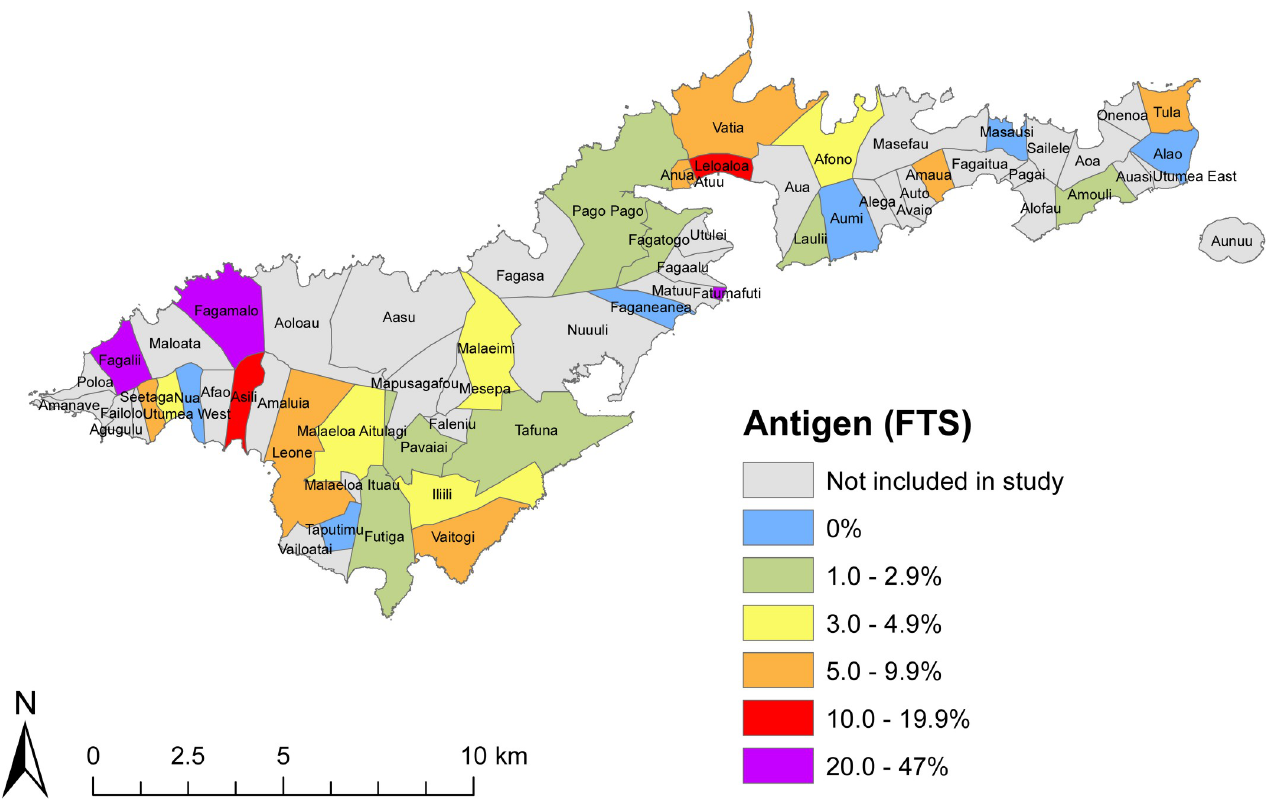
Fig 5. Adjusted seroprevalence by village in community survey (age � 8 years) of randomly selected villages and previously identified hotspots, American Samoa 2016.